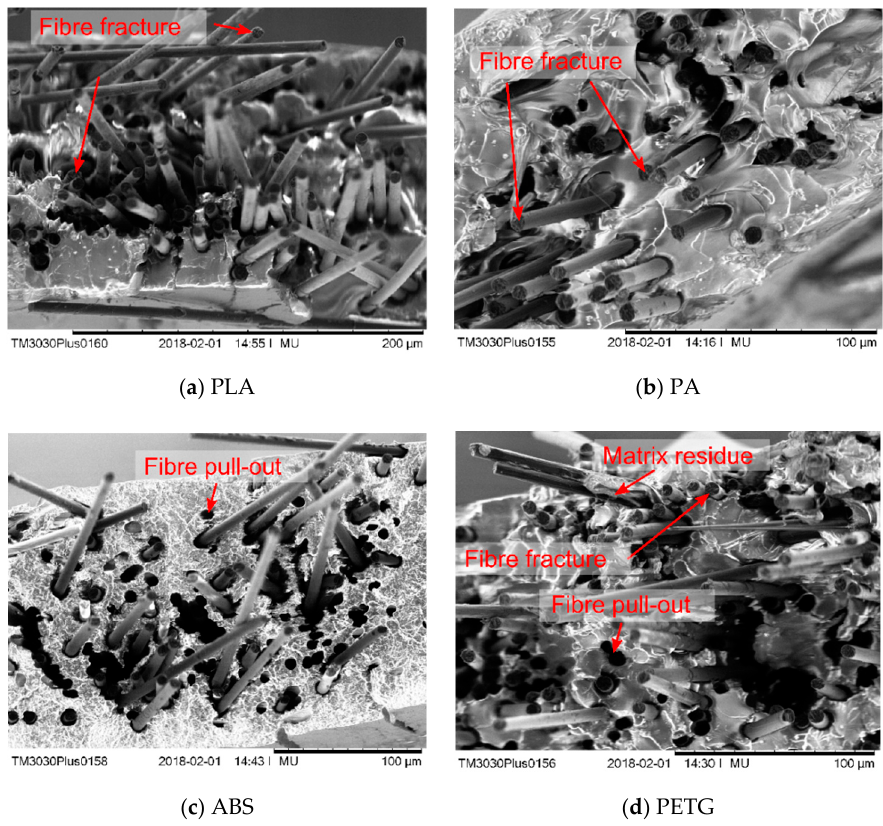
Figure 16. SEM micrographs of fracture surfaces of di ff erent ADFRCs, all for higher processing temperatures: ( a ) PLA ( b ) PA ( c ) ABS ( d )